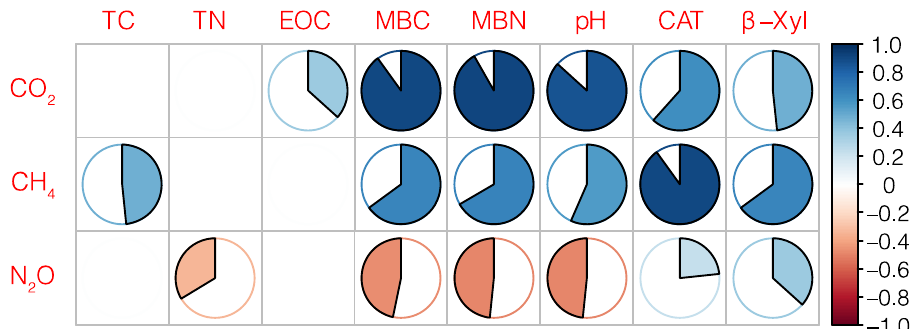
Figure 4. The correlations between cumulative greenhouse gas emissions and soil physicochemical properties. The shaded area represents the strength of the correlation. Empty boxes represent correlation absolute values of less than 0.2. TC: total carbon; TN: total nitrogen; EOC: easily-oxidized organic carbon; MBC: microbial biomass carbon; MBN: microbial biomass nitrogen; CAT: catalase; β‐ Xyl: β‐ xylosidase.